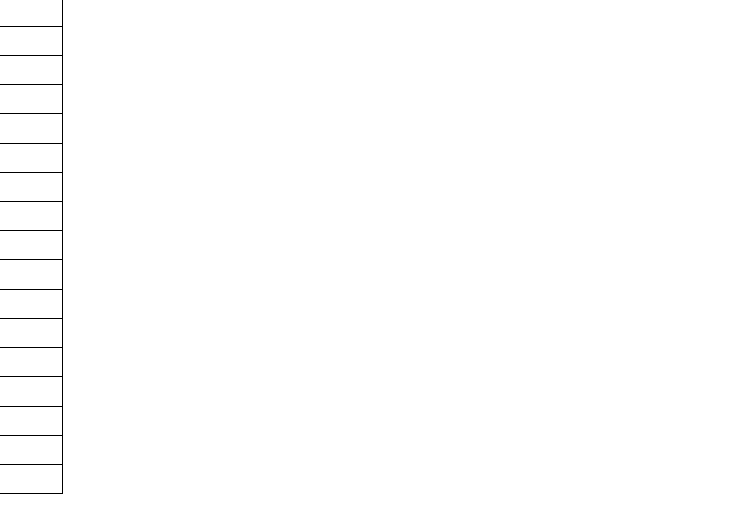
Table 8. Amino acid profile of 16 different